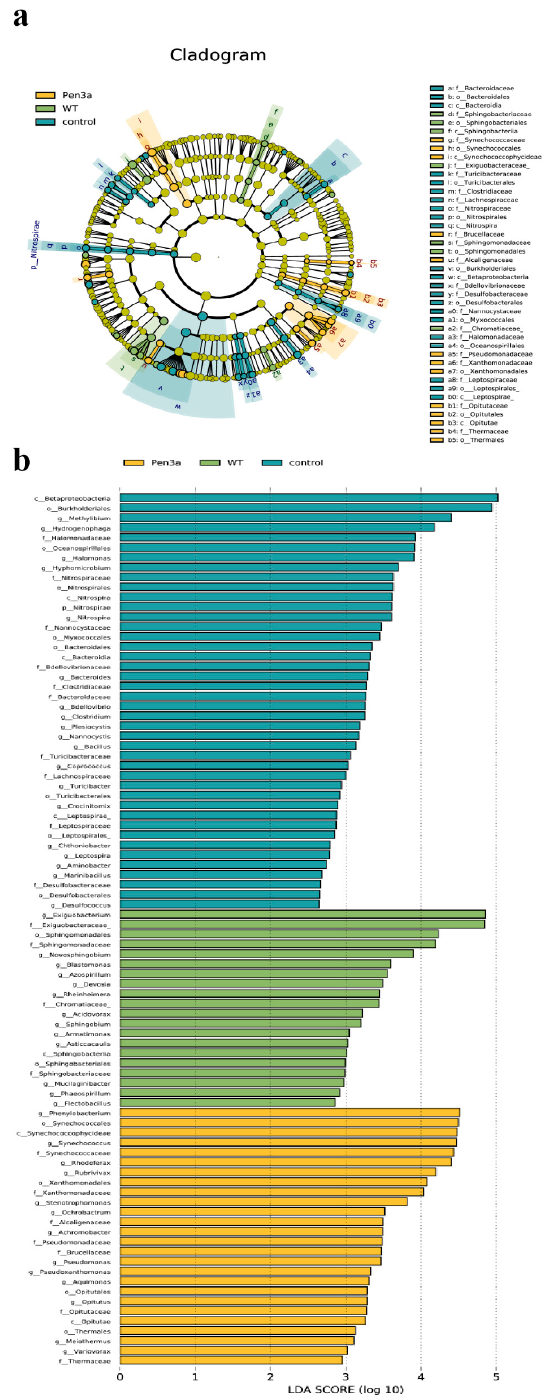
Figure 4. ( a ) LEfSe results on aquart microbial communities. Cladogram corresponds to di ff erent taxonomic levels of families and genera in the phylum. Each circle node represents a species. The yellow node represents no signi fi cant di ff erence between groups, and the non-yellow is the charac- teristic microorganism of the corresponding color group and the abundance is signi fi cantly higher in this group. Blue indicates the control group, green indicates wild-type treatment, yellow indicates transgenic antimicrobial peptide duckweed treatment. ( b ) Histogram of the LDA scores computed for abundance between three treatments. Each horizontal bar represents a species, and the length of the bar corresponds to the LDA scores. The higher the LDA value, the greater the di ff erence. The LDA scores of indicator microbiota of the three types of sediments were greater than 2.5 logs 10.